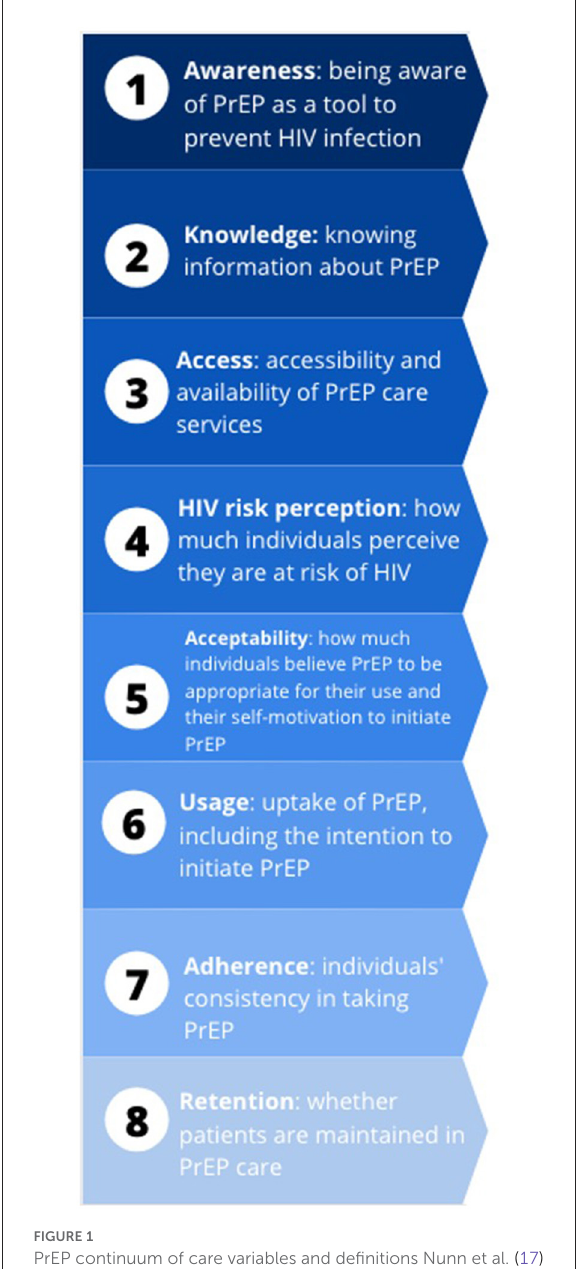
FIGURE1 PrEP continuum of care variables and definitions Nunn et al. (17)